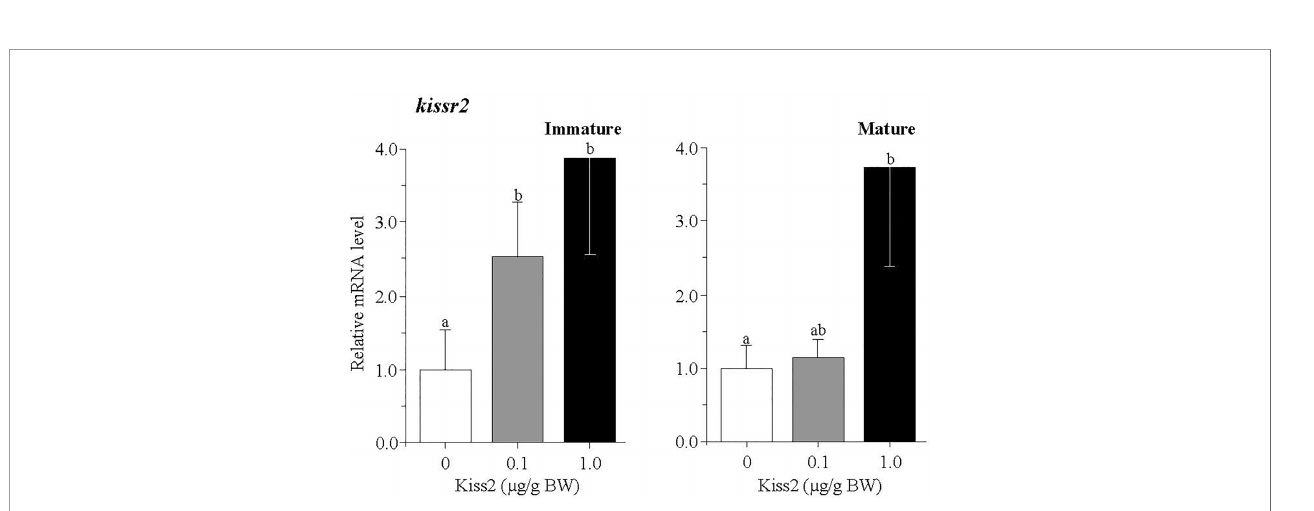
FIGURE 4 | Changes in the relative mRNA levels of kissr2 in the pituitary of grass puffer at immature and mature stages after intraperitoneal injection of gpKiss2 for the period of 12hrs. Values are presented as mean ± SEM (n = 6 − 8). Values accompanied by different letters are statistically signi fi cantly different ( p <